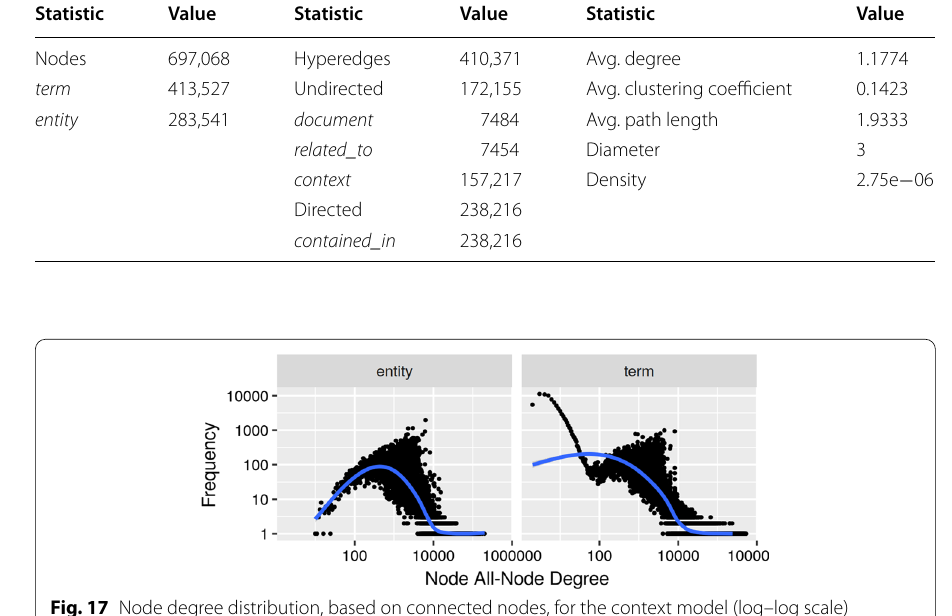
Table 4 Global statistics for the contextual similarity model Statistic